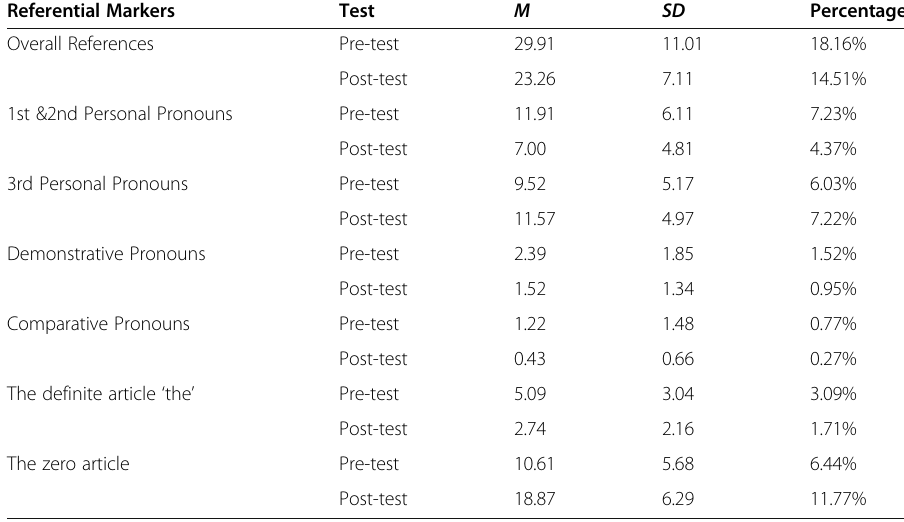
Table 4 Mean frequency, standard deviation, and proportion of referential markers subcategory Referential